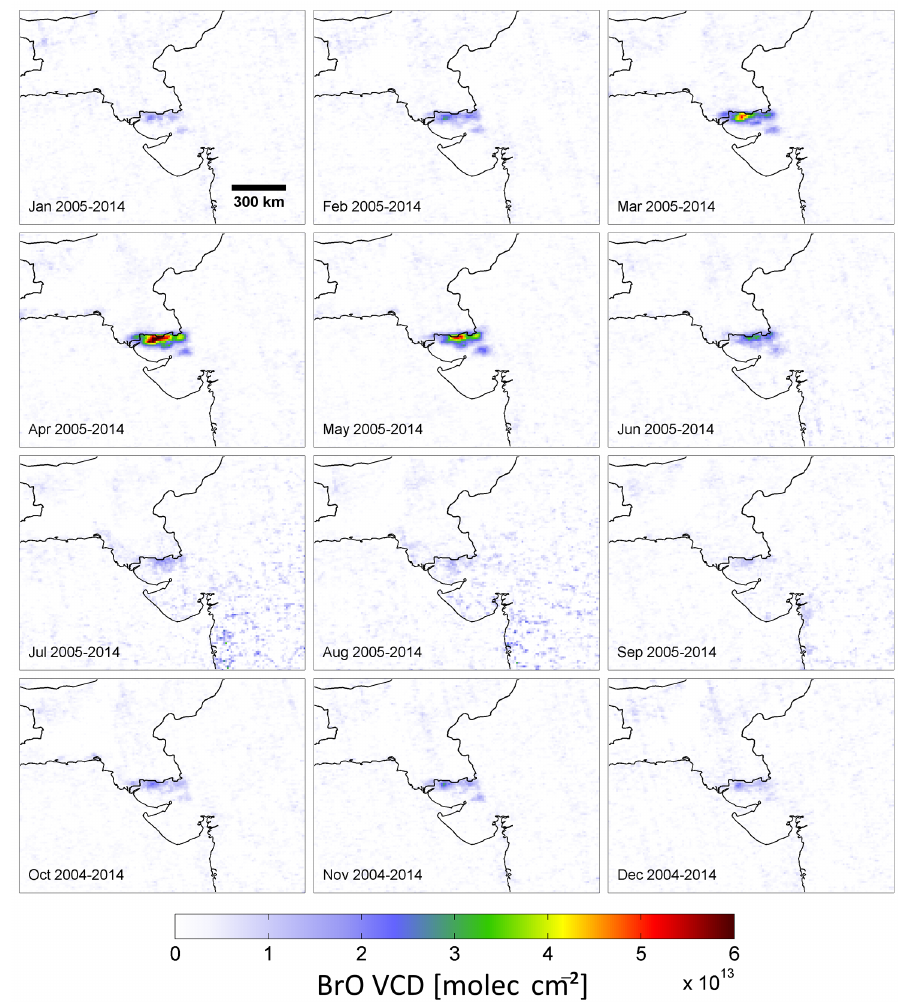
Figure 3. Seasonal variation of monthly mean BrO VCDs with CF < 30% over the Rann of Kutch as seen by OMI during 2004–2014. While maximum VCDs are clearly detected in April and May for the Great and Little Rann, only small enhancements can be seen during wintertime. Results during the monsoon season (July–September) include less measurements due to increased cloud frequency leading to a higher noise level, especially in the southeastern part of the region shown. Please note that OMI data are only available from October 2004 onwards, i.e. no data for January–September 2004 are